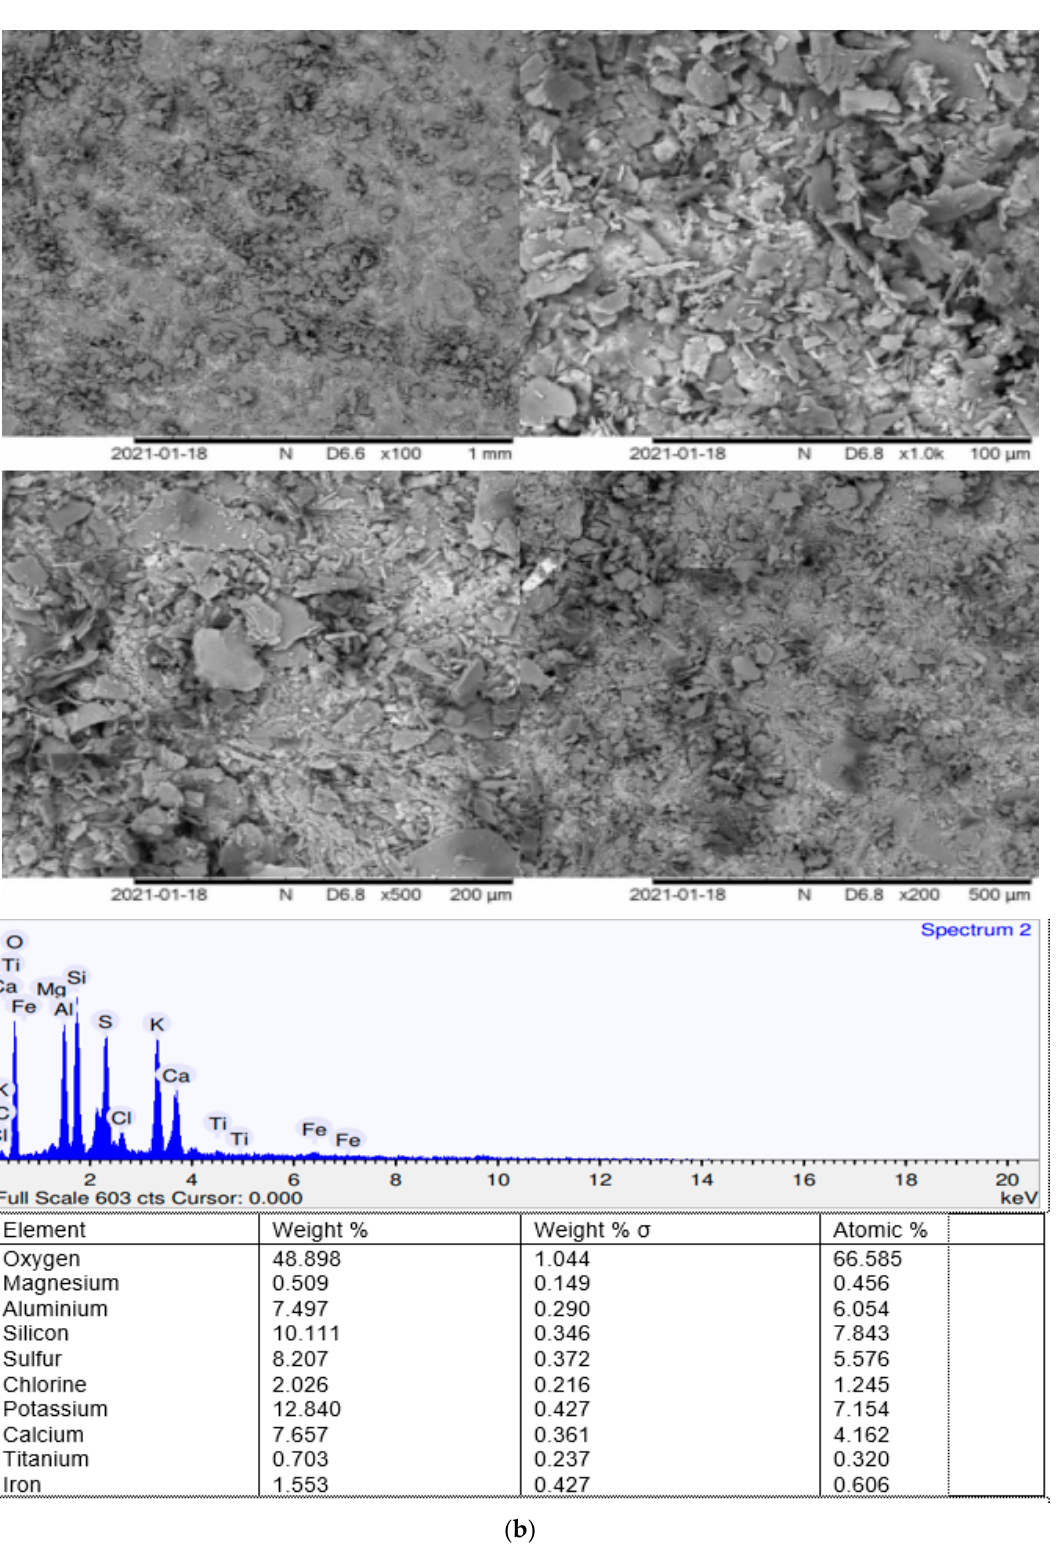
Figure 14. ( a ) SEM and EDX of kaolin and treated kaolin 28 days of curing. ( b ) SEM and EDX of treated kaolin of KG6P10 at 28 days of curing. treated kaolin of KG6P10 at 28 days of